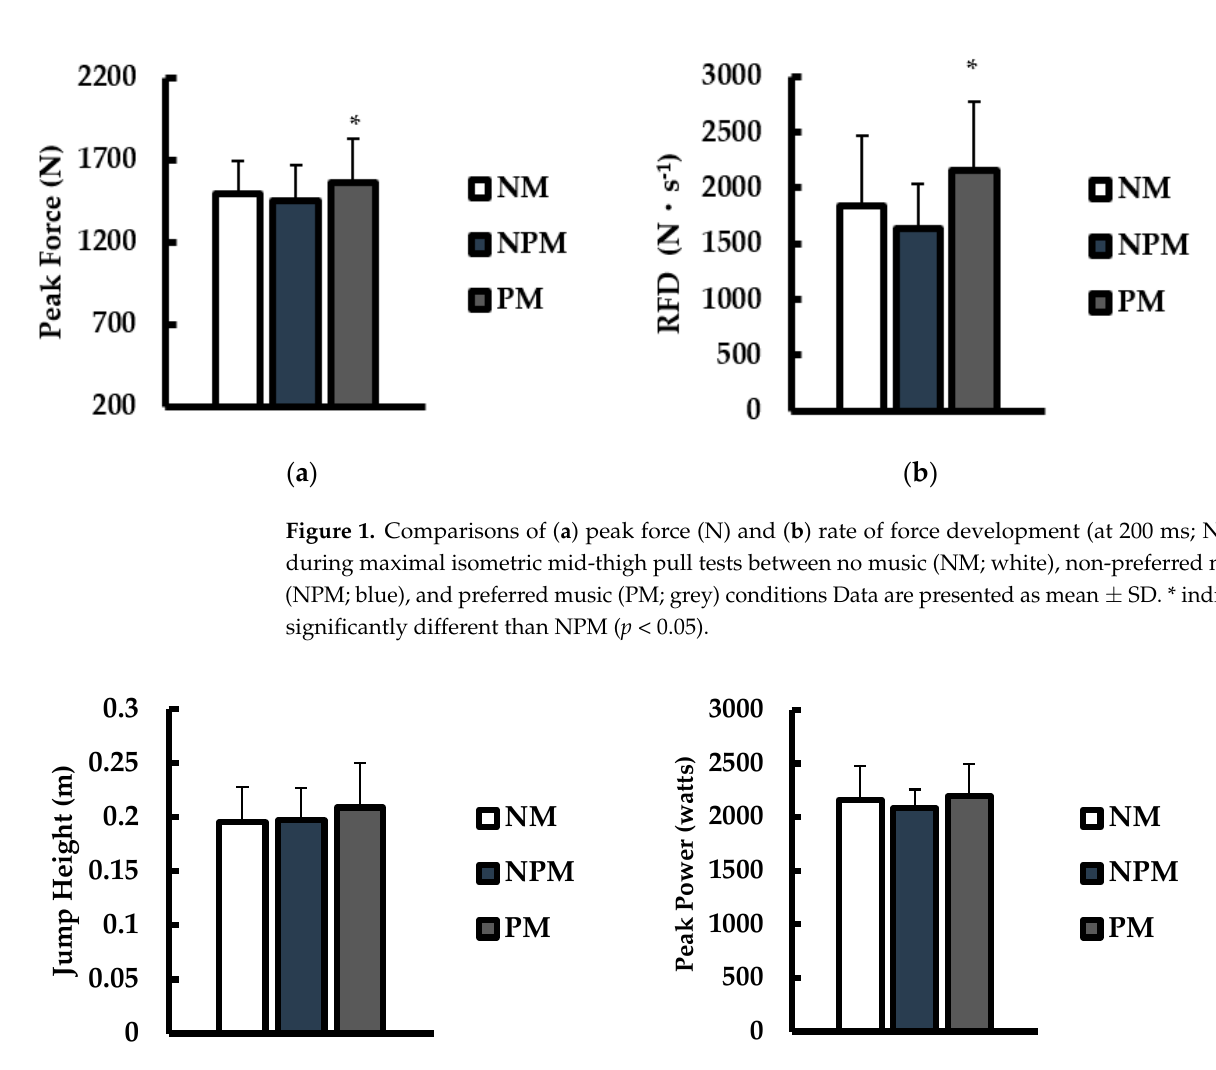
Figure 2. Comparisons of ( a ) jump height (m) and ( b ) peak power (watts) during the propulsive phase during countermovement jump tests between no music (NM; white), non-preferred music (NPM; blue), and preferred music (PM; grey) conditions. Data are presented as mean ± SD. Feelings of motivation (mm) and being psyched up (mm) are shown in Figure 3. For